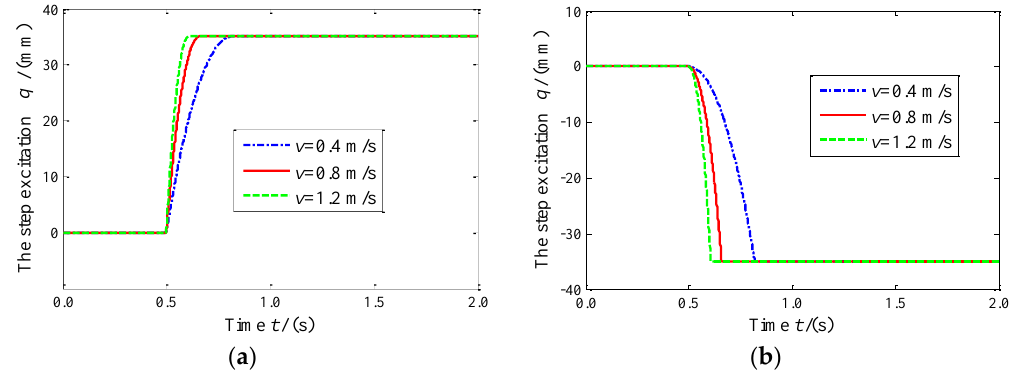
Figure 3. The time histories of the step excitation q for the wheelchair: ( a ) going up the step; and ( b ) going down the step.